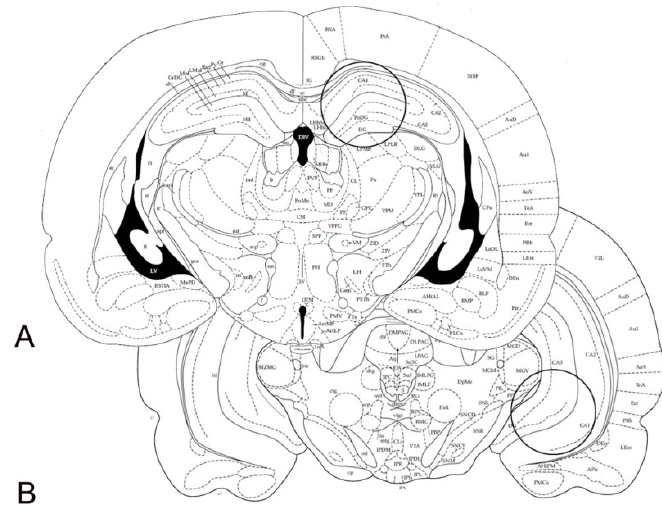
Figure 10. Schematic representation of two rat brain coronal sections (Figures 33 and 44, modified from Paxinos & Watson [121]). The circles denote the areas of the dorsal ( A ) and ventral ( B ) hippocampus, taken for western blot analysis, by means of a 2.5 mm punch. Stereotaxic coordinates (from Bregma): ( A ) − 3.30 mm, ( B ) − 6.04 mm.